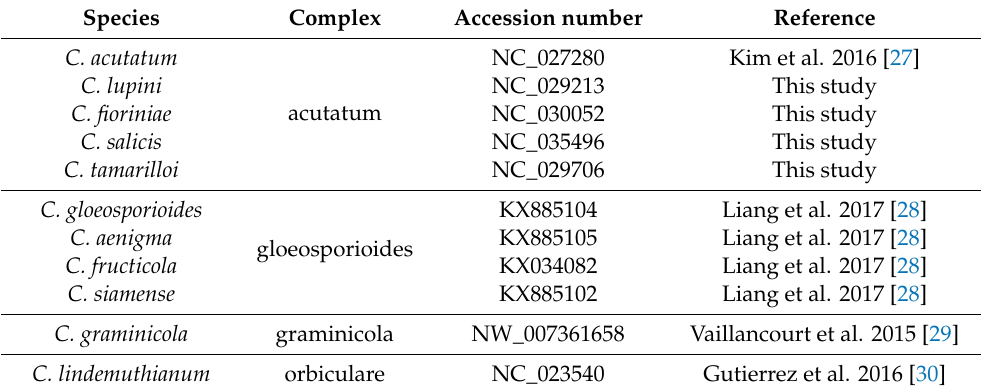
Table 1. GenBank accession numbers and references for Colletotrichum cp genomes used in this